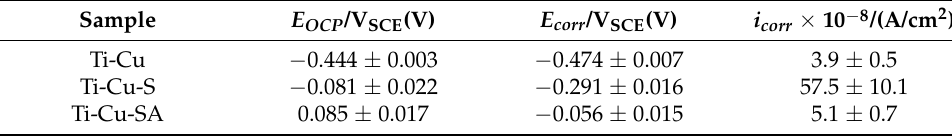
Table 1. Electrochemical data obtained from OCP and Tafel curves.